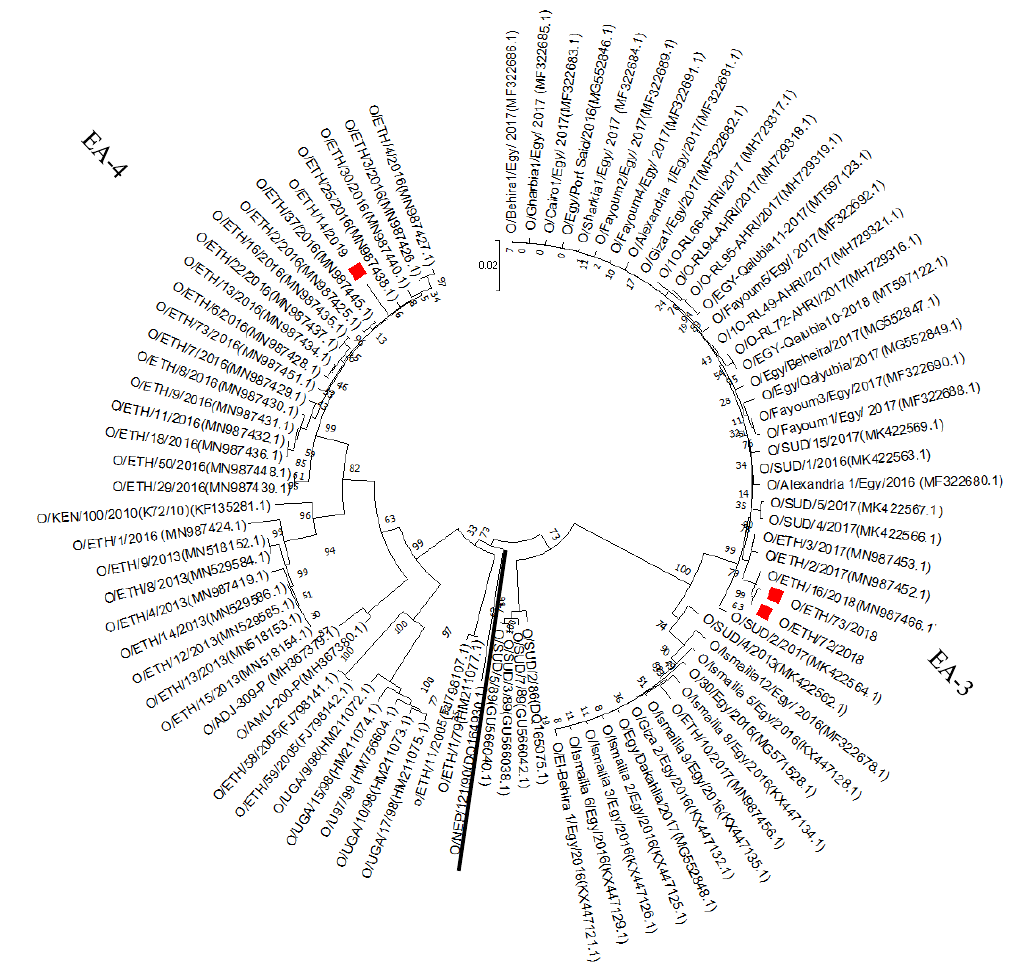
Figure 2. Mid-point-rooted neighbor-joining phylogenetic tree of serotype O FMDV local isolates in comparison with serotype O isolates from Ethiopia and other referenced counties. New isolates obtained from outbreak cases are indicated by ( ).